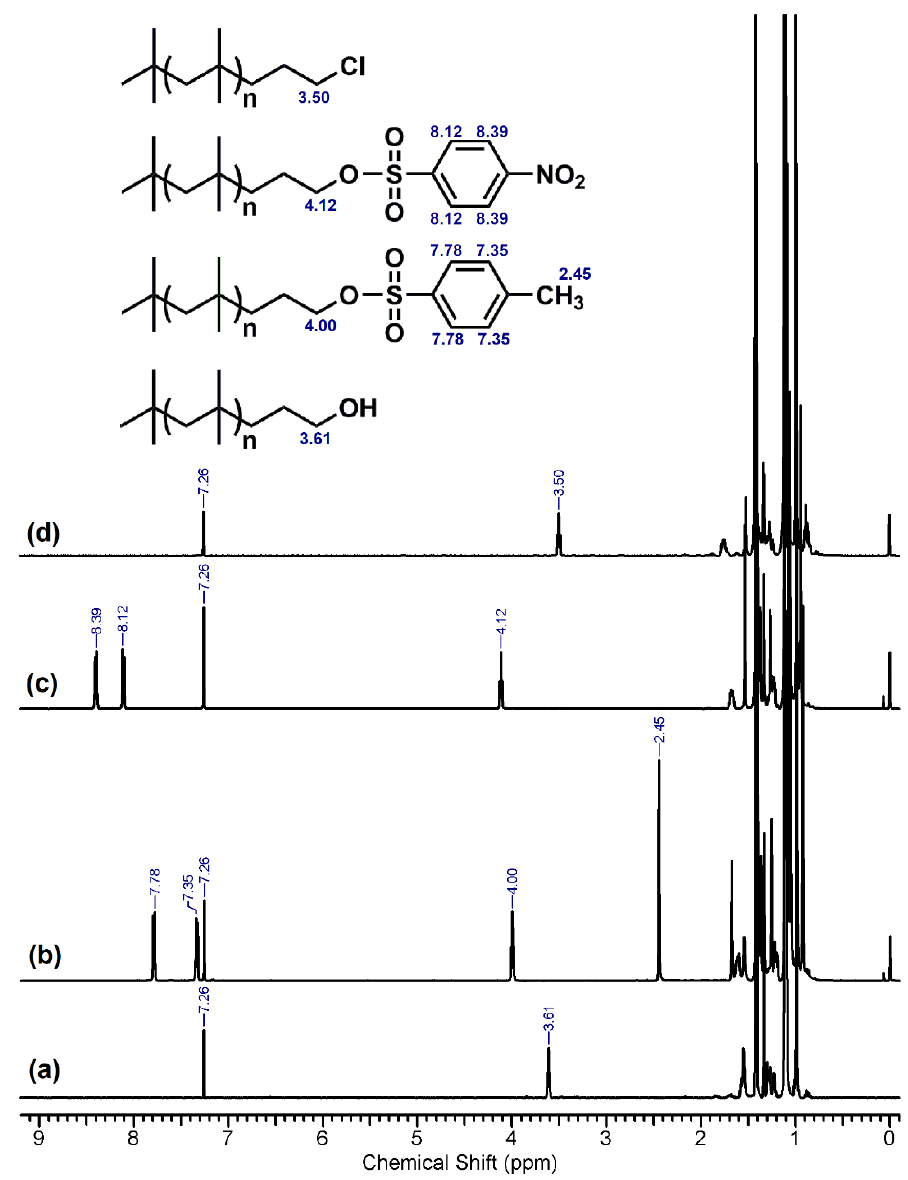
Figure 3. 1 H NMR spectra of PIB all -OH ( a ), PIB all -OTs ( b ), PIB all -ONs ( c ) and PIB all -Cl ( d ). Table 3. The effect of the reaction conditions on the tosylation of PIB all -OH at room temperature.